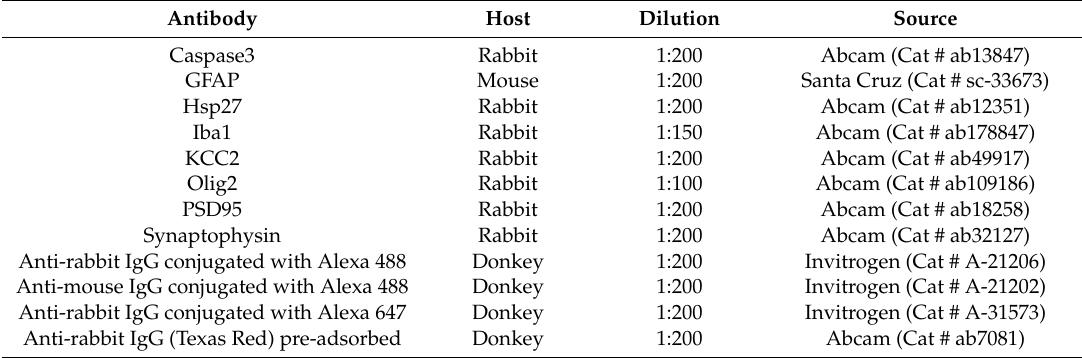
Table 1. Primary and secondary antibodies for immunofluorescence.